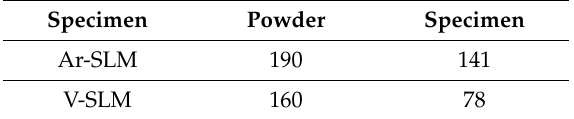
Table 6. Oxygen content of the powder and the SLM-fabricated specimens